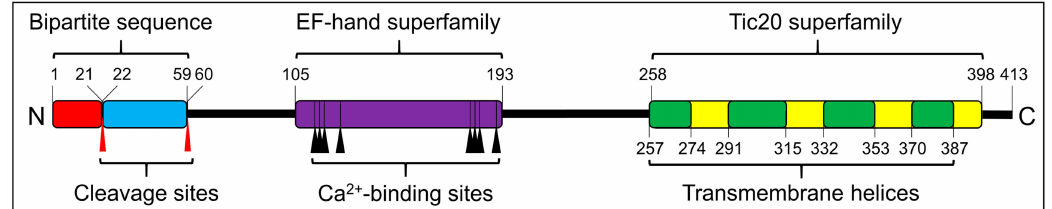
Figure 1. Schematic of the predicted SjTic20-14 protein structure. Signal peptide (red box), transit peptide-like sequence (blue box), EF-hand domain (violet box), Tic20 domain (yellow box), transmembrane region (green box), cleavage sites (red arrows), Ca 2 + -binding sites (black